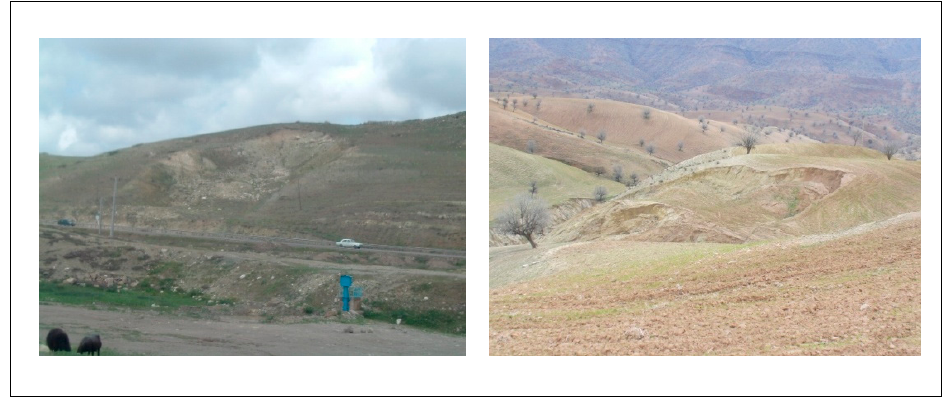
Figure 4. Field photographs show the pattern of landslide occurrences in some part of the present study area.